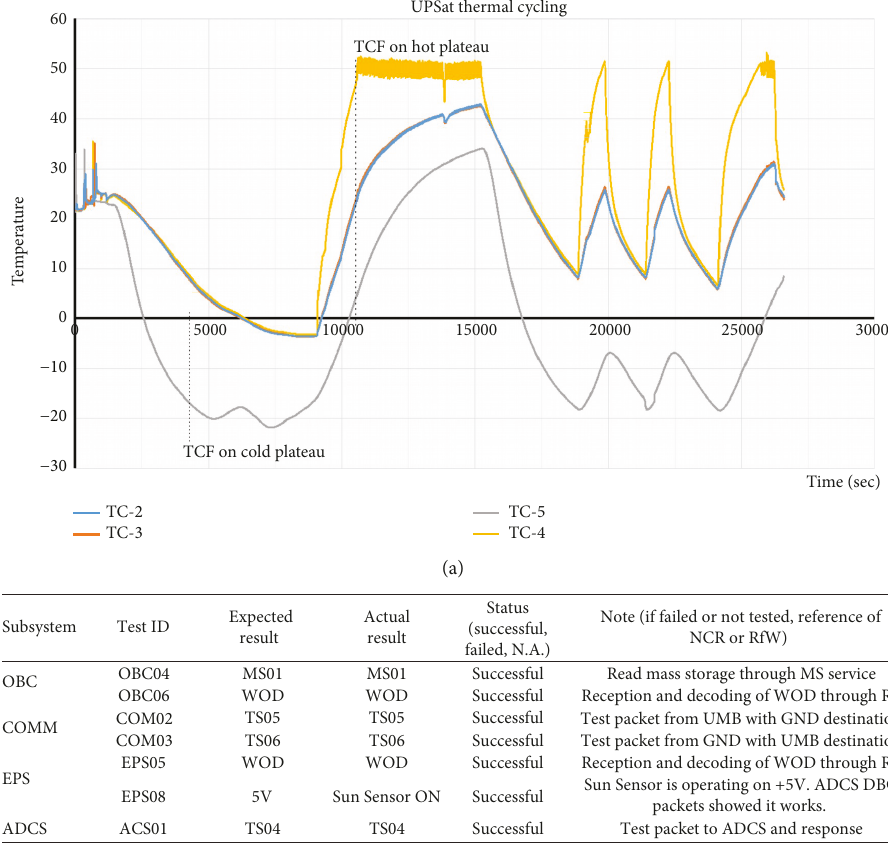
Figure 18: (a) Thermal cycling TC response (temperatures monitoring) and (b) some of the reference tests during thermal cycling.